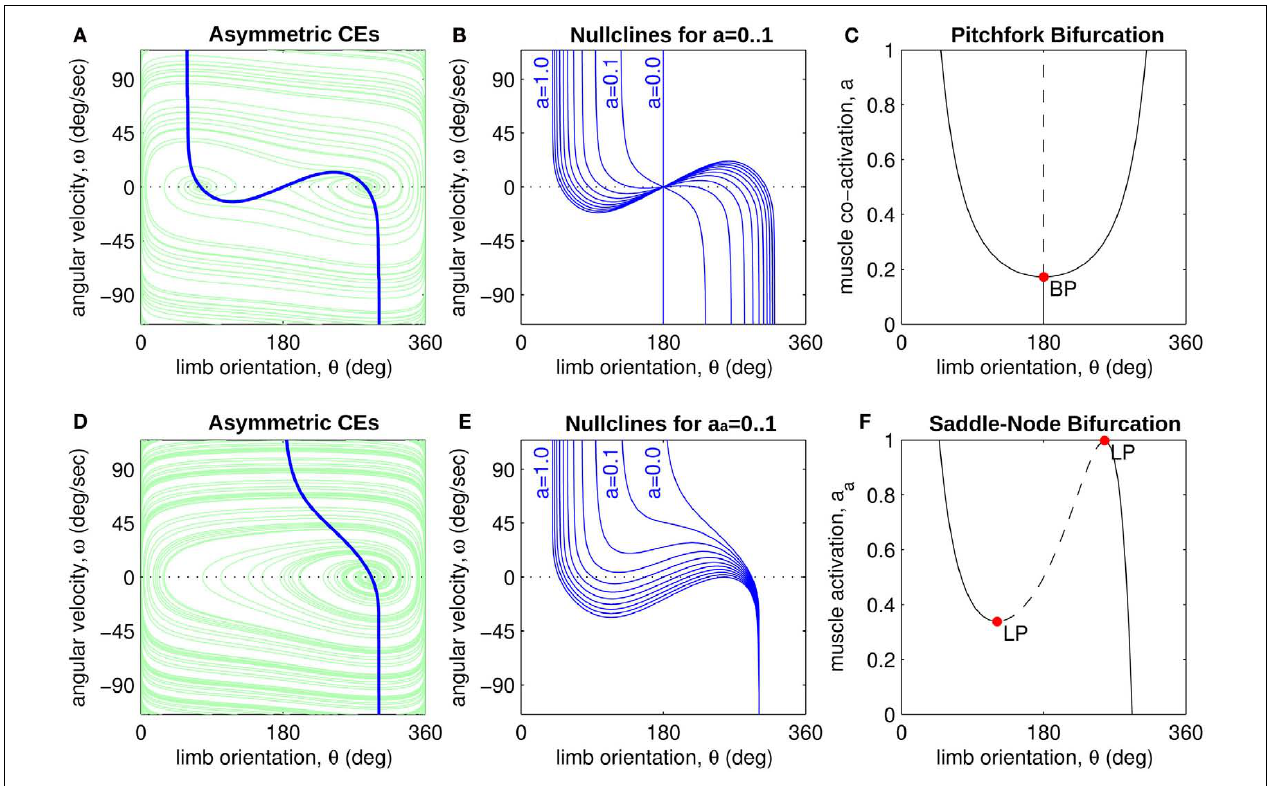
co-activation is increased. Solid lines indicate stable equilibrium points, FIGURE 4 | (A) Phase portrait of an isolated limb segment actuated by dashed lines indicate unstable equilibrium points.The branch point (BP) opposing muscles with asymmetric CE force-length properties ( ˆ θ = ˆ θ = π − 1 ) at 50% co-activation ( a = a = 0.5). All other marks the onset of bistability ( a = 0.172). (D) Same as (A) except here 0 a 0 b a b a a = 0., a b = 0.5 and only a single stable equilibrium point ( θ = 292˚) is parameters are identical to those of Figure 3 . One unstable equilibrium point is observed at ˆ θ = 180 ◦ and two stable equilibrium points are observed. (E) Same as (B) except here a b = 0.5 is held fixed while a a is observed at ˆ θ = 76 ◦ and ˆ θ = 284 ◦ respectively. (B) Nullclines for the same manipulated from 0 to 1. (F) Bifurcation plot showing the emergence of bistability through a saddle-node bifurcation as muscle activation a a is limb segment after manipulating muscle co-activation ( a = a a = a b ) from 0 to 1 in steps of 0.1. (C) Bifurcation plot showing the onset of bistability in increased while a b = 0.5 is held fixed.The limit points (LP) mark the onset the equilibrium positions through a pitchfork bifurcation as muscle ( a a = 0.338) and offset ( a a = 0.998) of